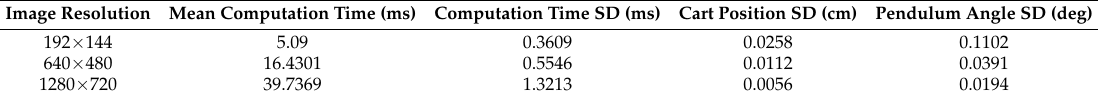
Table 4. Effect of image resolution on computation time and measurement noise.